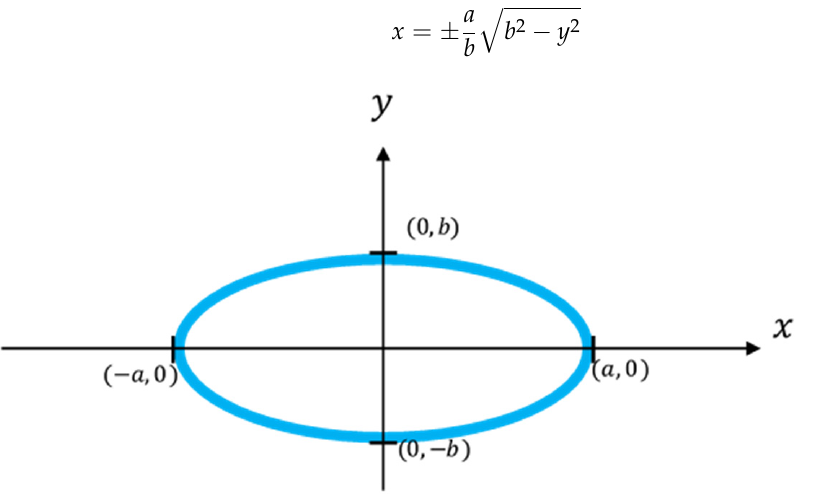
Figure 6. An ellipse centered at the origin.